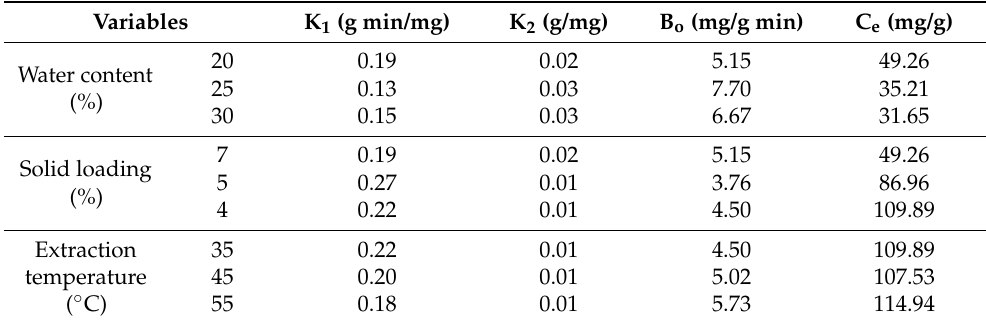
Table 2. Kinetics parameter for Peleg’s